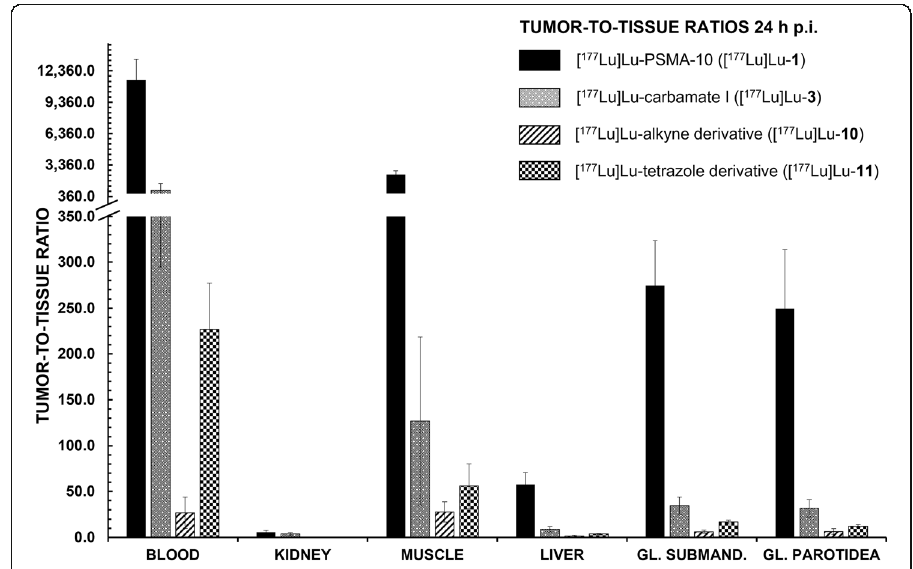
Fig. 5 Tumor-to-tissue ratios of [ 177 Lu]Lu-PSMA-10 ([ 177 Lu]Lu- 1 ), [ 177 Lu]Lu- 3 , [ 177 Lu]Lu- 10 and [ 177 Lu]Lu- 11 in selected organs at 24 h p.i. ( n = 4 for [ 177 Lu]Lu- 10 and n = 5 for all other